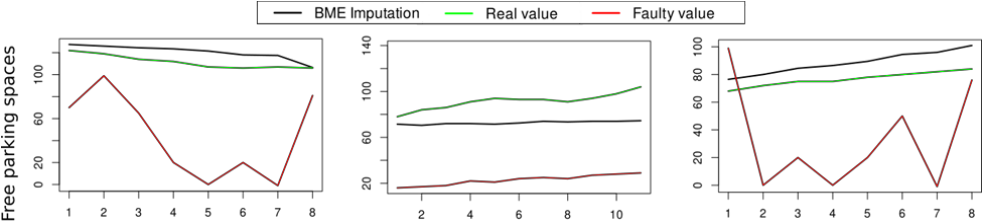
Figure 6. Comparison of actual and recovery values at the anomalous